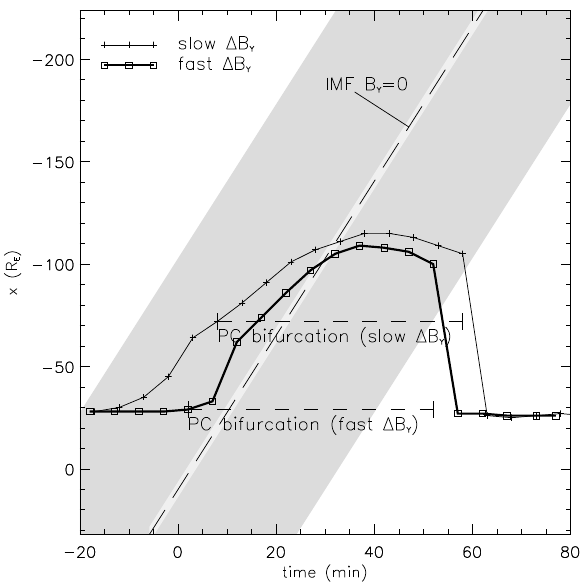
Fig. 6. The length of the closed field line region versus time for the fast (run 2a) and the slow (run 2b) IMF B y sign-change case. The time is given in minutes after the center of the sign-change region has passed the dayside magnetopause. The tailward propagating IMF sign-change region and the time interval during which a polar cap bifurcation occurs are marked for both runs.